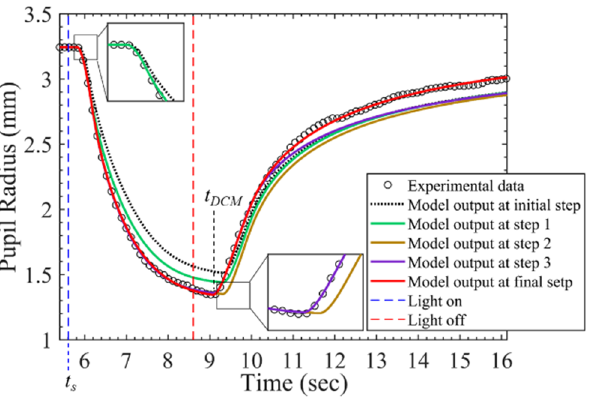
Figure 5. PLR inherent model output at different stages during parameter searching process.